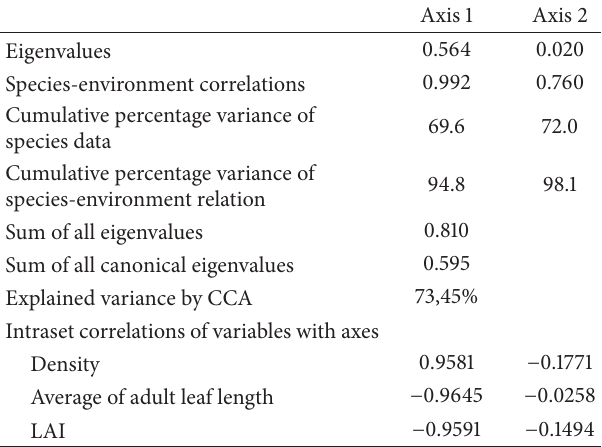
Table 4: Summary of canonical correspondence analysis (CCA) of the three data matrices (epiphytic microalgae, stations, and biometric parametersvariables).